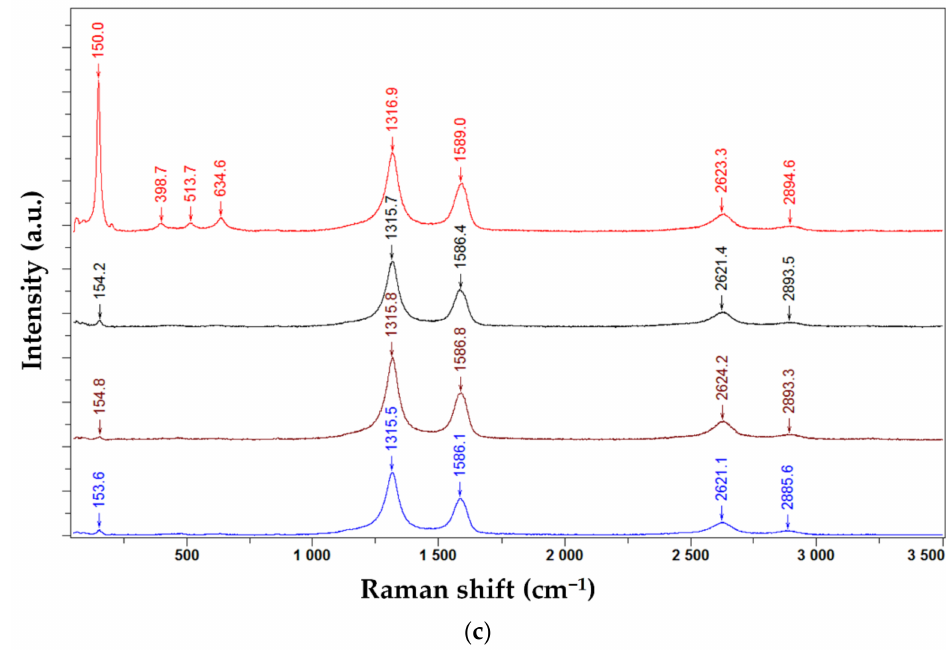
Figure 7. Raman spectra of the solid-state films of the CNHox/TiO 2 /PVP nanocomposite of: ( a ) 1/1/1, ( b ) 2/1/1, and ( c ) 3/1/1 ( w/w/w ), deposited on glass and measured in four points of the